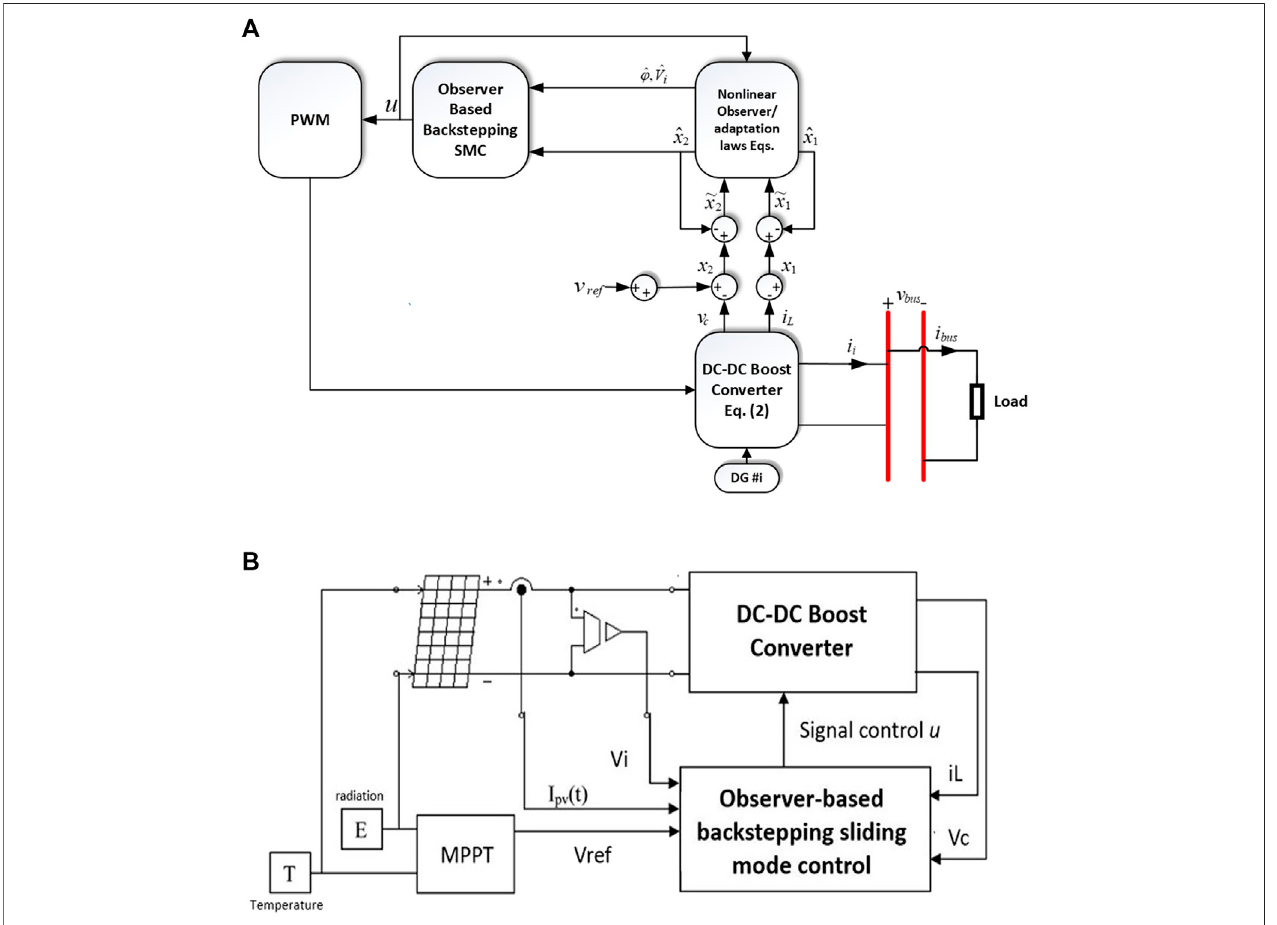
FIGURE 5 | Block diagram of the proposed system (A) implemented for DC microgrid; (B) implemented for PV system with MPPT.